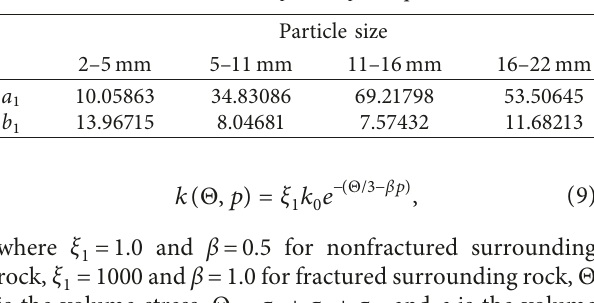
Figure 6: Particle diameter: (a) 5mm–10mm; (b) 10mm–15mm; (c) 15 mm–20mm; (d) 20 mm–26.5mm. Table 1: Values of a b 1 and 1 in equation